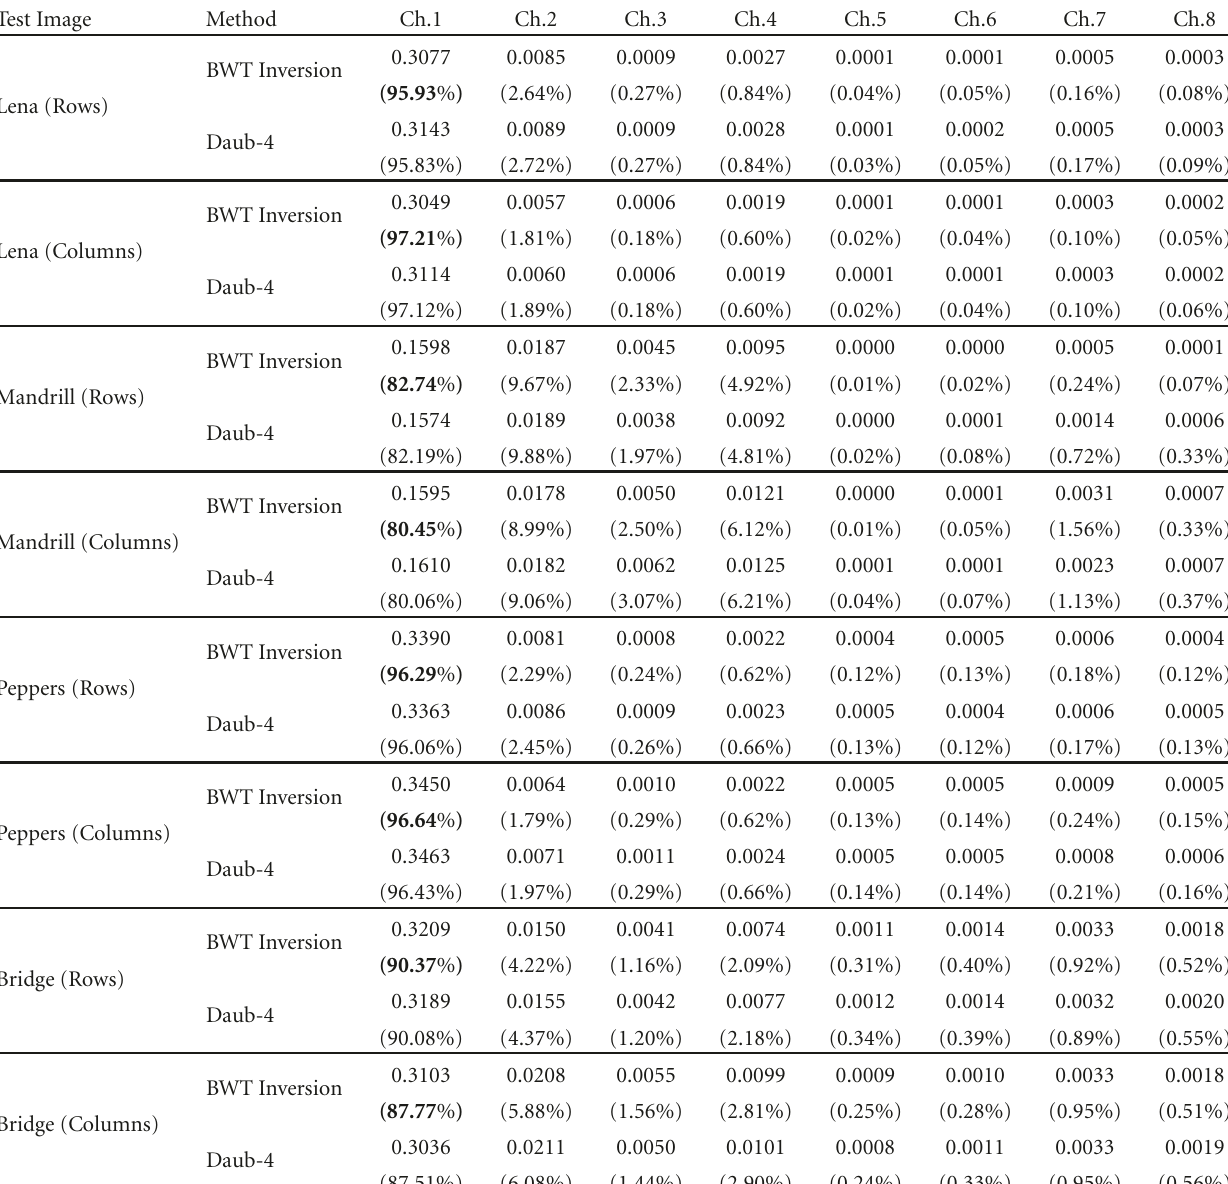
Table 8: The channel variances and percentages obtained by the BWT Inversion and the Daub-4 filter